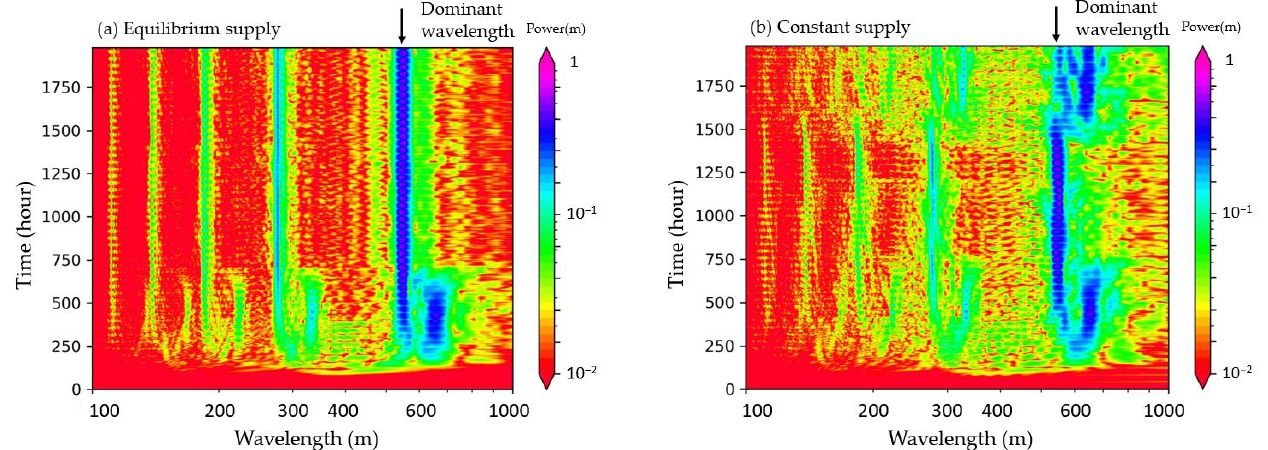
Figure 7. FFT analysis of dominant wavelength in case 1: ( a ) Equilibrium sediment supply. ( b ) Constant sediment supply.